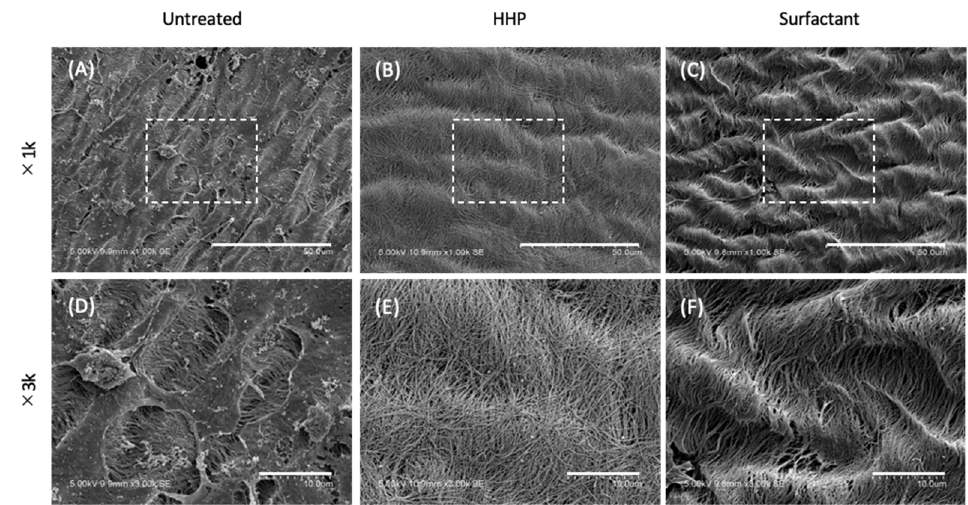
Figure 3. SEM observation of the ( A , D ) untreated, ( B , E ) HHP-decellularized, and ( C , F ) surfactant- decellularized pericardia. Scale bars: ( A – C ) 50 µm, ( D – F ) 10 µm.